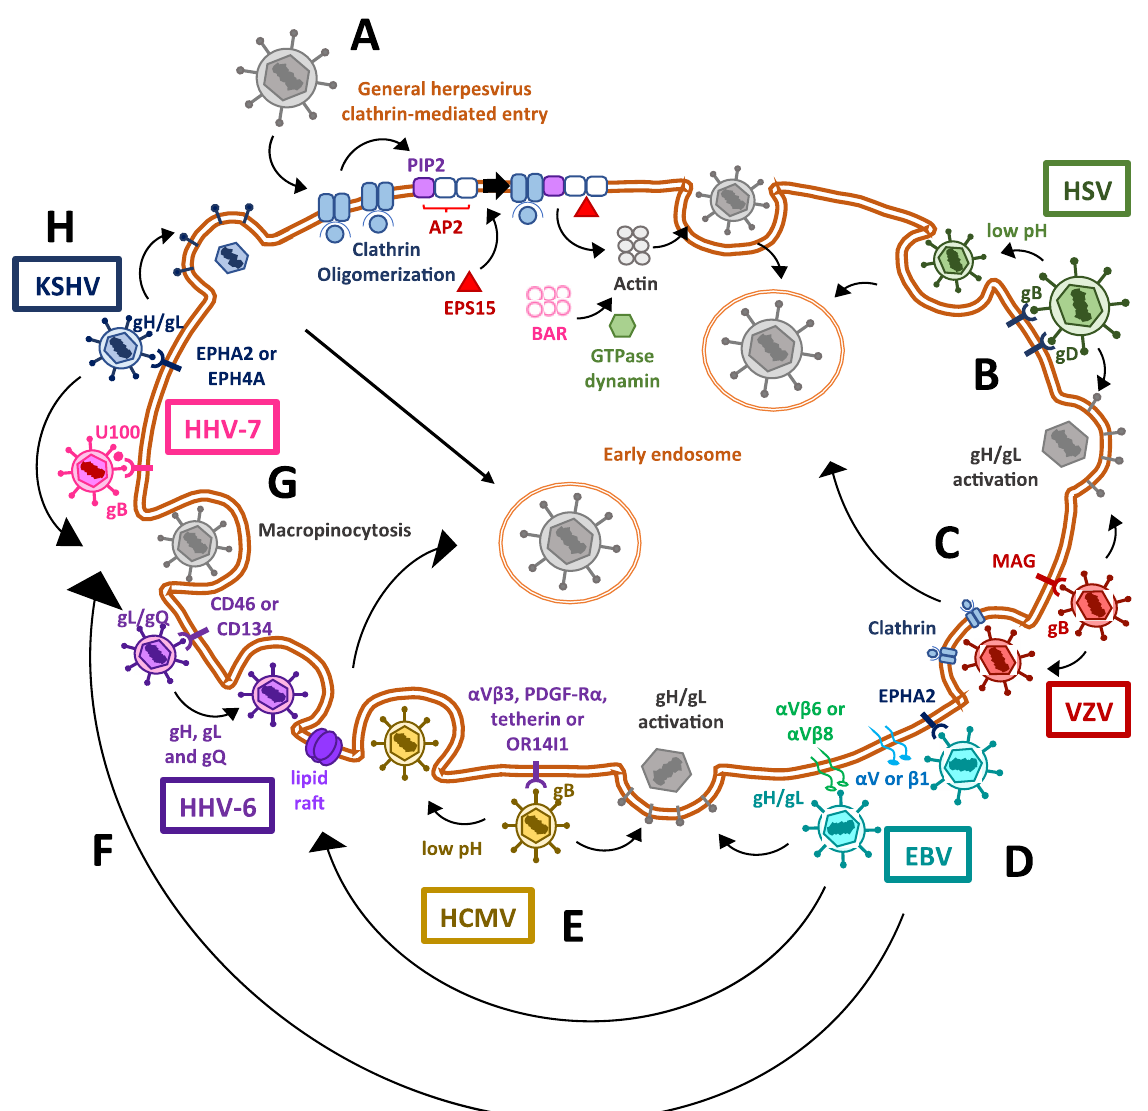
Figure 1. Mechanisms used by human herpesviruses to enter host cells. ( A ) Clathrin-mediated entry for herpesviruses in general. Herpesviruses induce clathrin oligomerization, together with the recruitment of host factors and adapter proteins, which also induce the polimerization of actin filaments and lastly the invagination of the cell membrane, thanks to the GTPase activity of dynamin. ( B ) Cell entry mechanisms exploited by human herpesviruses type 1 and type 2 (HSV-1 and HSV-2). The binding of viral glycoproteins B and D to their ligands triggers dimerization of the gH/gL complex, which causes the activation of the fusogenic activity of gB, enabling the release of the viral capsid into the cytosol. On the other hand, viral capsid delivery through the endosomal pathway has also been described, which is associated with endosomes having a low pH. ( C ) The mechanism used by varicella-zoster virus (VZV) for entering cells is also mediated by the gH/gL complex, but clathrin-mediated entry has also been described for this virus. ( D ) The Epstein–Barr virus (EBV) has been described to enter the cell through its binding to the EPHA2 receptor. Alternatively, other entry pathways exist, such as that mediated by BMRF-2 binding to integrins, causing gH/gL complex activation and gB-mediated fusion of membranes; lipid raft-mediated endocytosis; or viral entry through micro- and micropinocytosis. ( E ) The human cytomegalovirus (HCMV) mainly enters the cell via the activation of the gH/gL complex, triggering gB-mediated membrane fusion, but a low pH-dependent endocytosis mechanism has also been reported, involving a viral protein complex binding to host OR14I1. ( F ) The entry mechanisms exploited by human herpesviruses 6 (HHV-6; HHV-6A and HHV-6B) mainly occurs by endocytosis through lipid rafts. ( G ) The only entry mechanism described so far for the human herpesvirus 7 (HHV-7) is mediated by a fusogenic process mediated by the gH/gL complex. No endocytic pathway has been described yet for this virus. ( H ) Finally, Kaposi’s sarcoma-associated herpesvirus (KSV) infects the cells through a gB-mediated membrane fusion pathway, clathrin-mediated endocytosis and may also induce micro- and